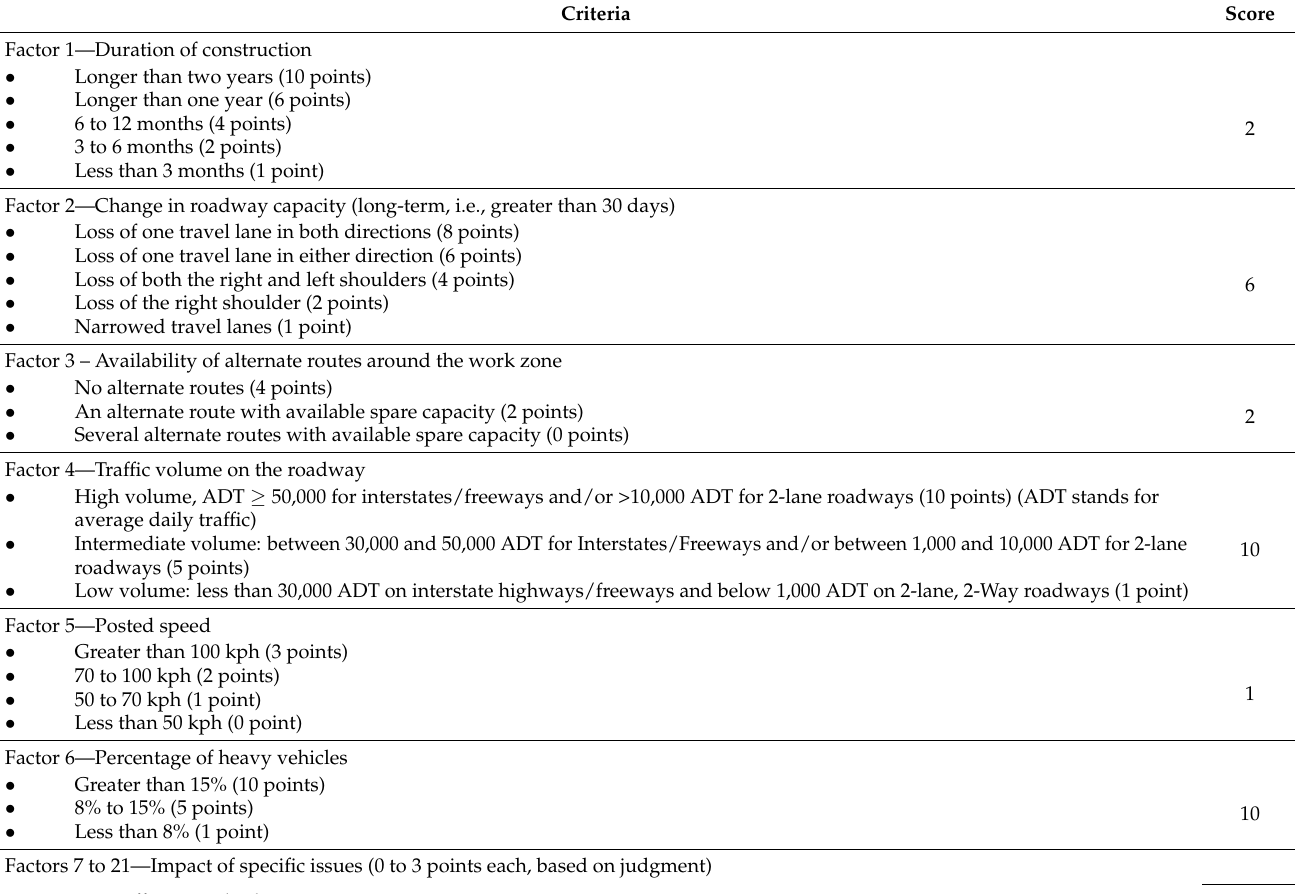
Table 8. Work zone ITS feasibility assessment for the case